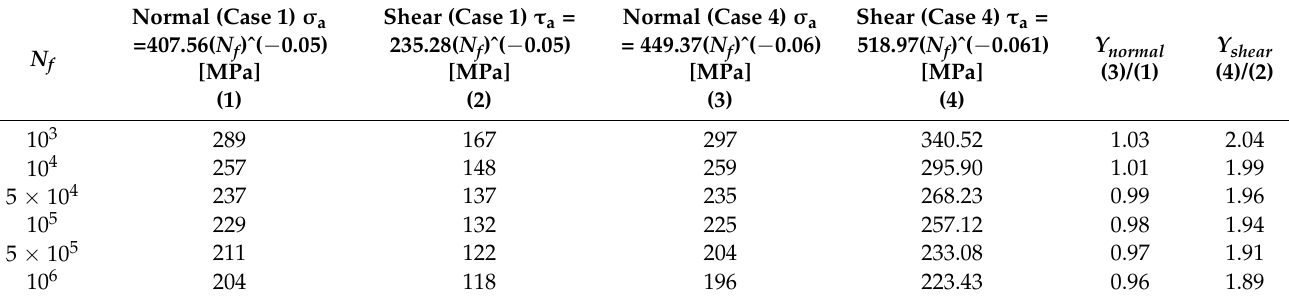
Table 7. Y results for case 1 vs. case 4—AISI303.